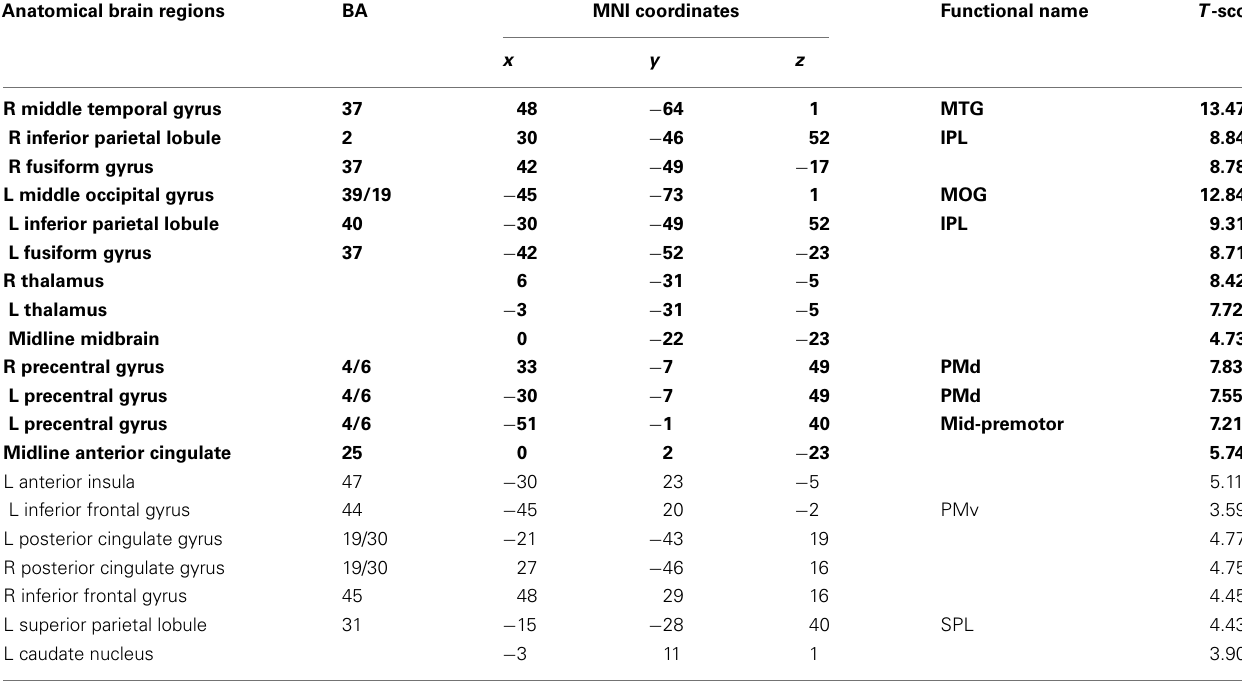
Table 1 | Main effect of observing dance compared to a still body. Anatomical brain regions